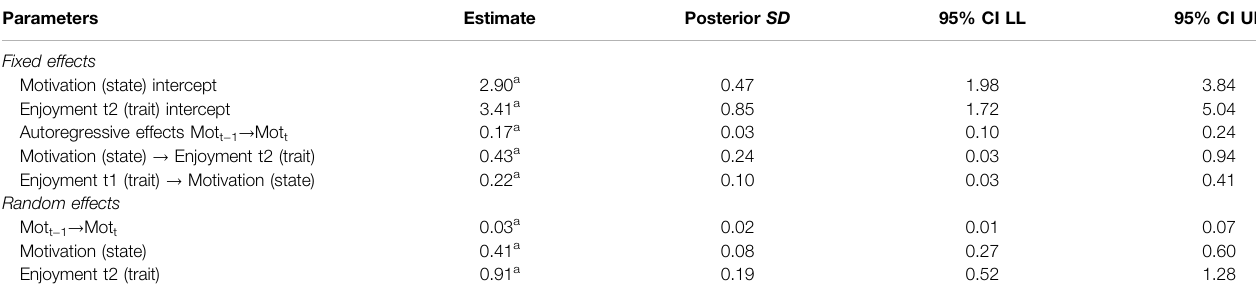
TABLE 2 | Unstandardized parameter estimates for the multilevel autoregressive model explaining the effects of momentary motivation (state) on pre-service teachers ’ general enjoyment of conducting experiments in class (trait variable on the between level). Parameters